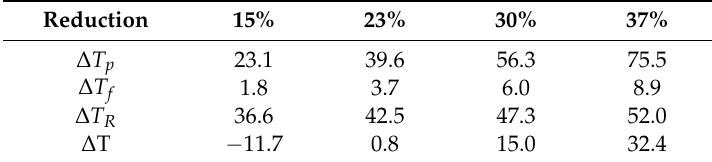
Figure 4. Microstructure of the four plates after the 3rd rolling process at 350 ◦ C:( a ) plate A; ( b ) plate B; ( c ) plate C; and ( d ) plate D. Table 3. Temperature change for low speed rolling with different rolling reductions